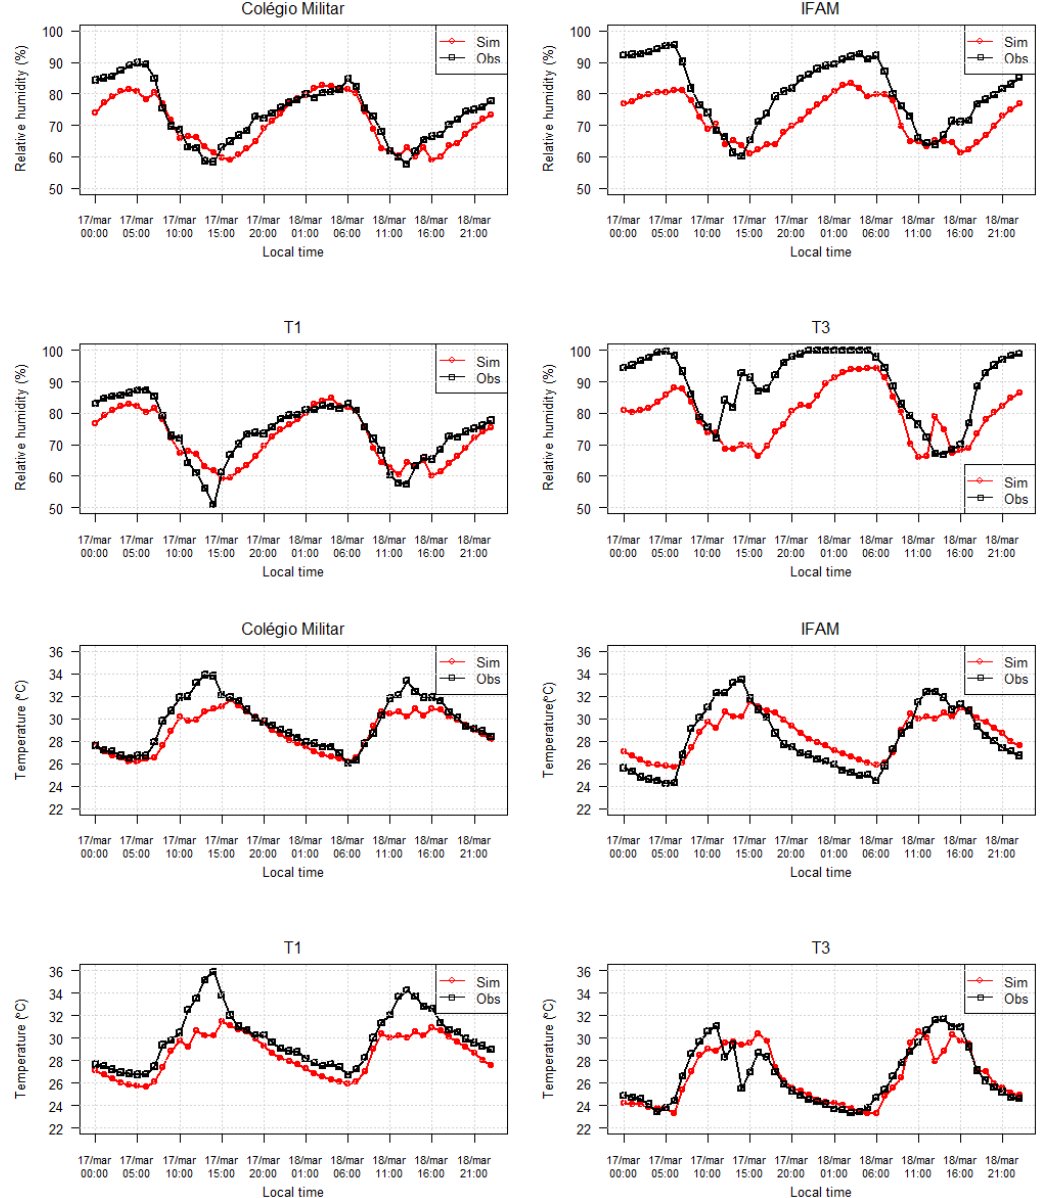
Figure 4. Temporal evaluation of temperature and relative humidity simulated and observed for Colégio Militar, IFAM, T1 and